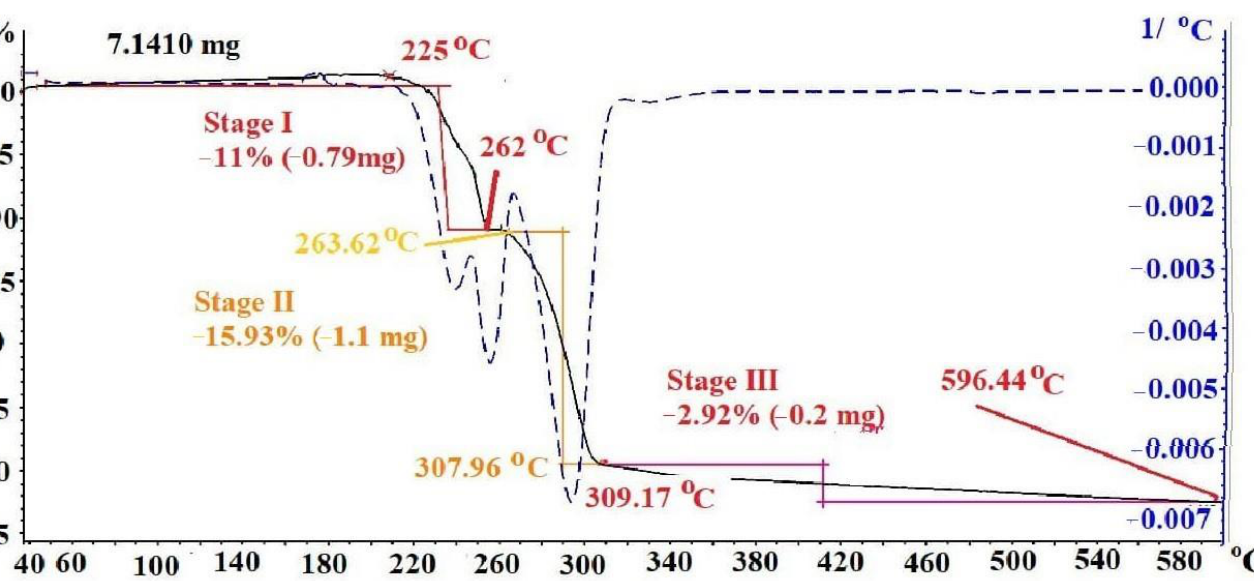
Figure 3. IR spectrum of silver maleate.